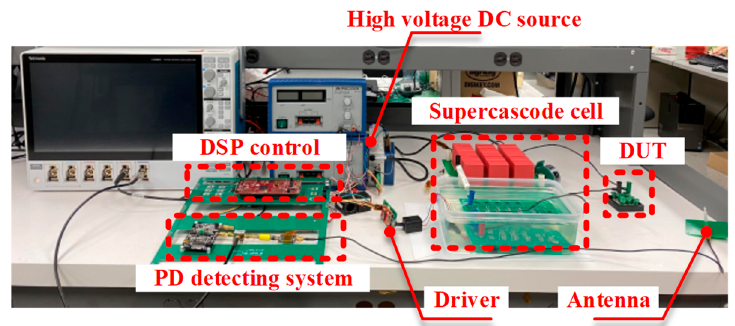
Figure 11. PD measurement setup under square voltages [86].